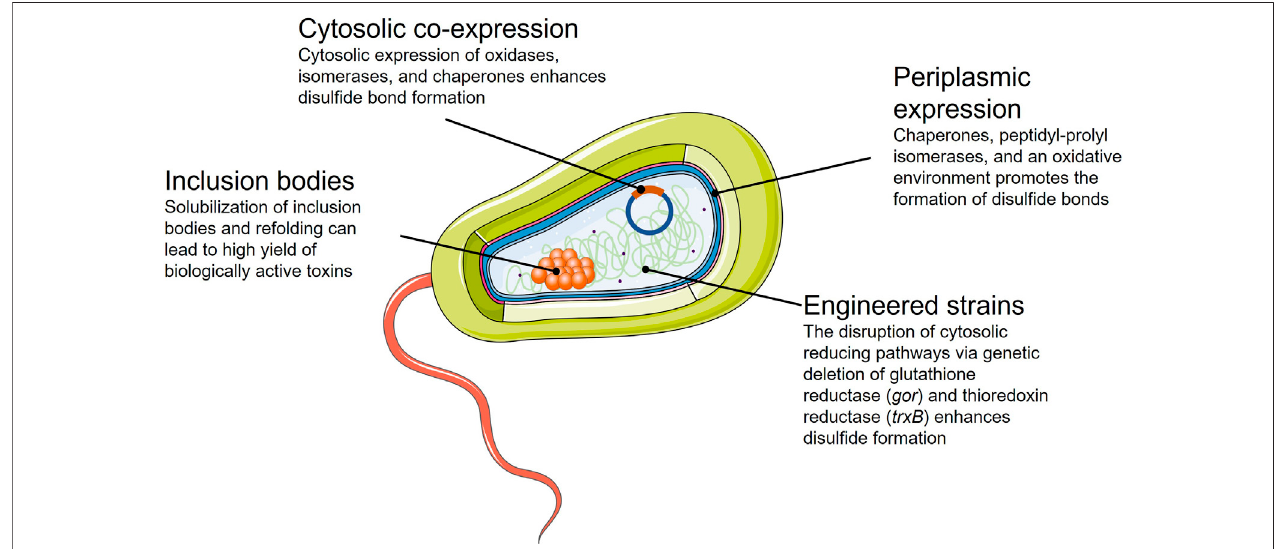
FIGURE 3 | Summary of the strategies available for the successful expression of toxins in an E. coli bacterial expression system.